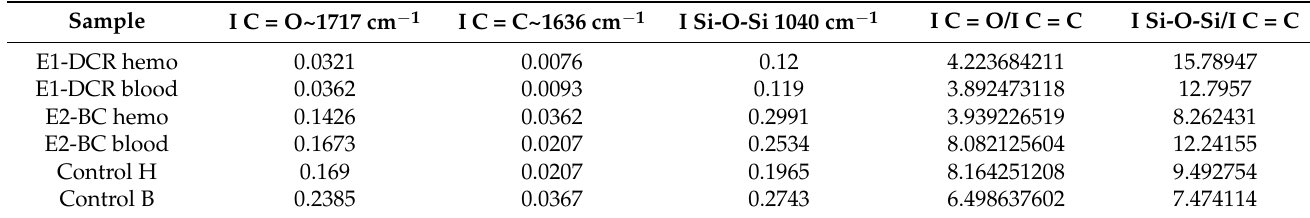
Table 2. Absorption maximum intensity values considered for estimating the interaction of composite materials with media containing blood and hemoglobin.